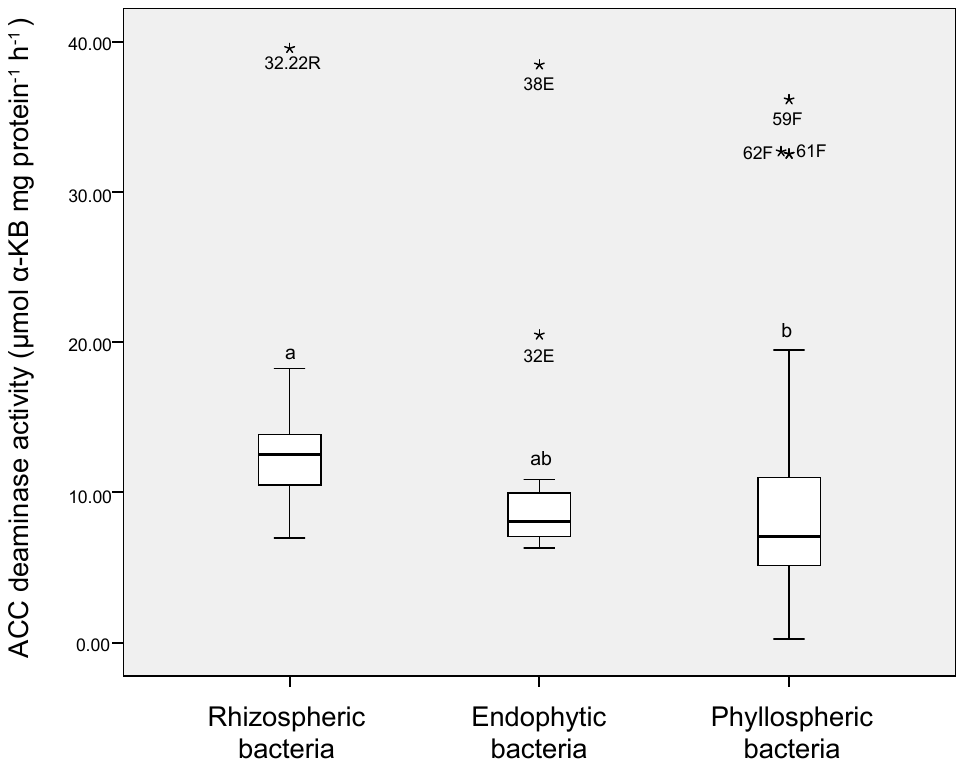
Figure 4. Boxplot of the 1-aminocyclopropane-1-carboxylate (ACC) deaminase activities of heterotrophic bacteria isolated from the rhizosphere, endosphere, and phyllosphere of Antarctic vascular plants. The centerline of each box represents the median, the top and bottom of boxes represent the 25th and 75th percentile of data, respectively, and the top and bottom of the error bars represent the 5th and 95th percentile of data, respectively. α -KB: α -ketobutyrate. Asterisks represent outliers. Small letters indicate significant differences ( p ≤ 0.05) among samples.